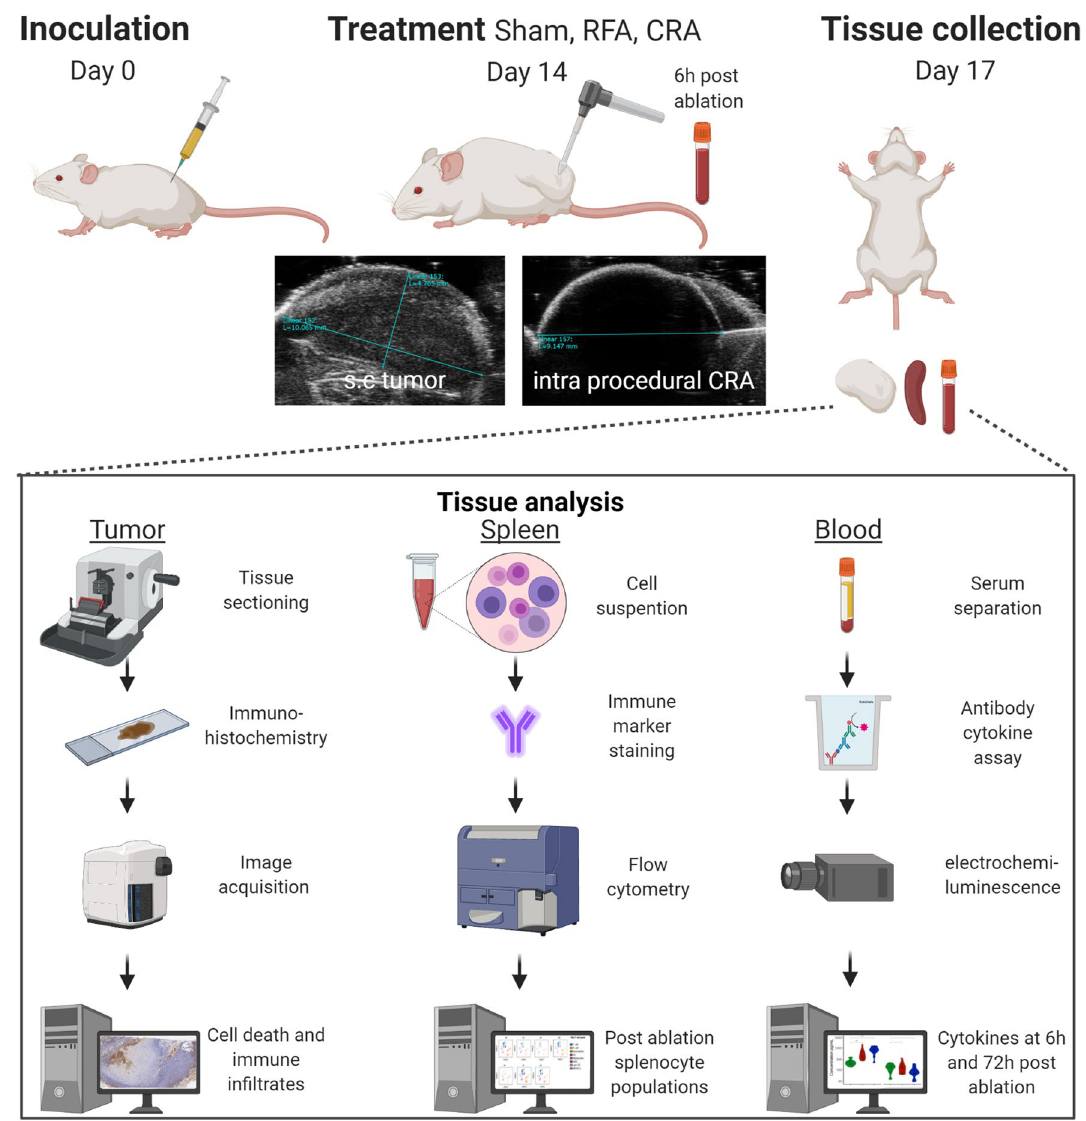
Figure 1. Study design and methods. Mice were subcutaneously inoculated with CT26 colon cancer cells. After 14 days, tumors were treated with sham procedure, radiofrequency ablation (RFA), or cryoablation (CRA) using ultrasound guidance. Three days post ablation, mice were sacrificed, and tumor, spleen, and serum were harvested. Tumors were analyzed by immunohistochemistry for cell death, apoptosis, and immune cell infiltration. Splenocyte cell suspensions were stained with multiple antibodies and expression of various immune cell sub-populations were measured with flow cytometry. Circulating cytokines were measured at two time points: 6 h post ablation blood draw and 3 days post ablation at